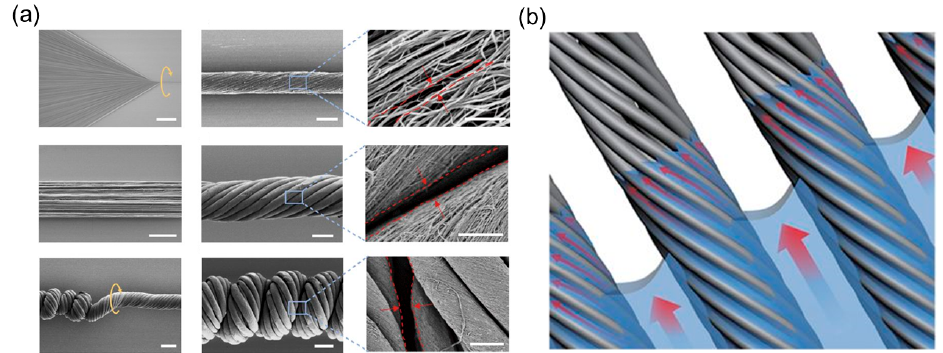
Figure 12. CNT-based helical structures mimicking Towel Gourd tendrils. ( a ) Groups of scanning electron images showing the fabrication process of the hierarchical helical fibers based on twisting MWCNTs. first row: dry-spinning (left, scale bar 500 µ m, primary fiber (middle, scale bar 10 µ m) and the nanoscale gaps between MWCNTs (right, scale bar 500 nm). Second row: bundle of primary fibers (left, scale bar 200 µ m), twisted primary fibers (middle, scale bar 30 µ m) and the microscale gaps between primary gaps (right, scale bar 2 µ m). Third row: coiling of multi-ply primary fibers when twisting exceeds the threshold (left, scale bar 50 µ m), hierarchical helical fiber (middle, scale bar 30 µ m) and gaps inside HHF (right, scale bar 10 µ m); ( b ) Hierarchical gaps, including microscale gaps between primary fibers and nanoscale gaps between MWCNTs, facilitate the solution’s infiltration; with permission from Nature Publishing